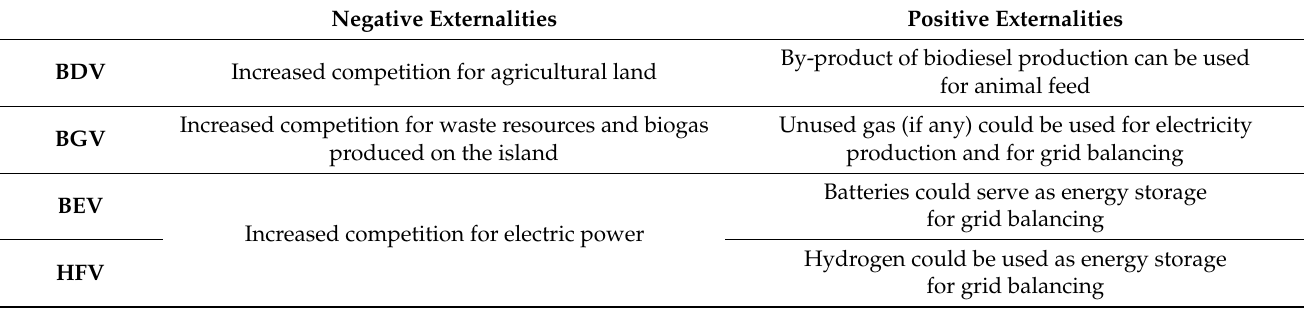
Table 3. Potential negative and positive externalities by